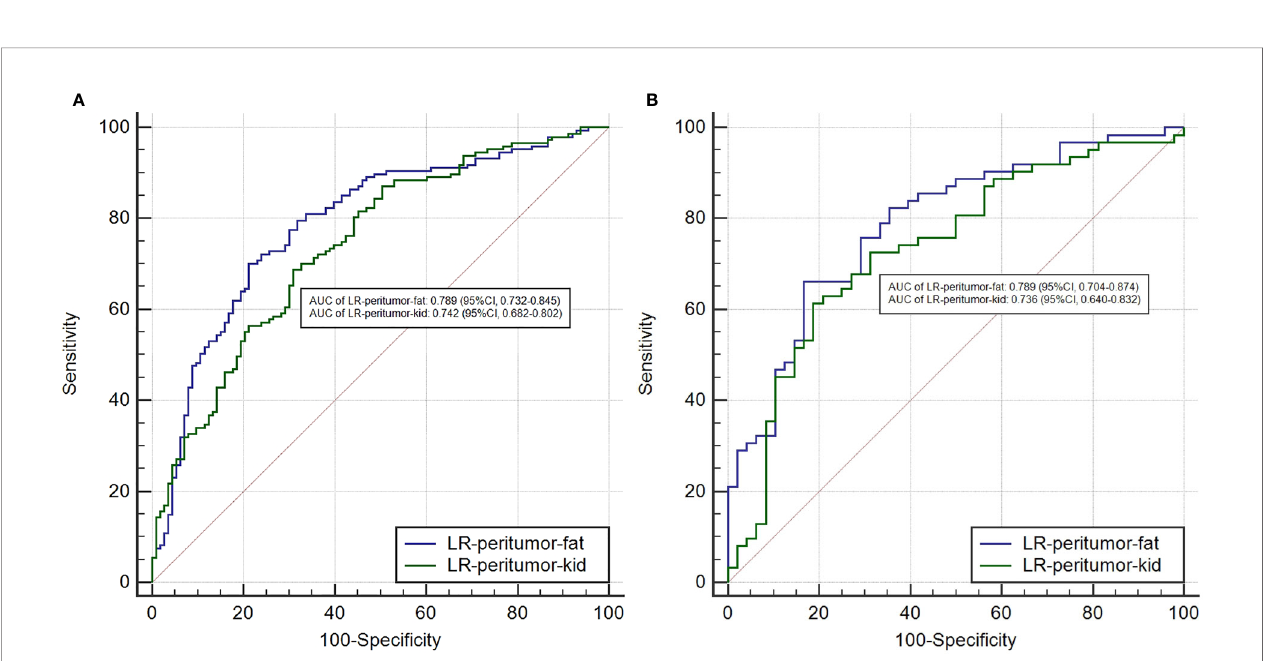
FIGURE 3 | The comparison of AUCs between the LR-peritumor-fat and LR-peritumor-kid in the training cohort (A) and the validation cohort (B) .